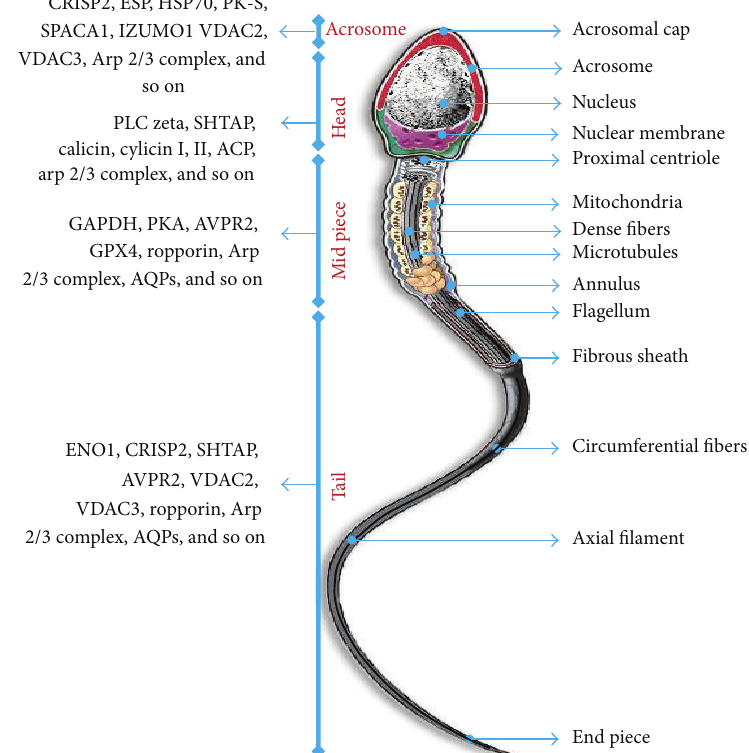
Figure 3: Diagram showing a mature human spermatozoon with its different parts. Previously published studies were used as a reference to summarize the list of proteins localized in different regions of the spermatozoon by immunolocalization. Proteins localized in acrosome, head, midpiece, and tail are mainly involved in capacitation and acrosomal reaction, spermatozoa-oocyte interaction (zona binding), energy production and metabolism, and motility and metabolism, respectively. The localization of a single protein at multiple sites in the sperm cell indicates its potential involvement in different physiological processes of the spermatozoon. The listed proteins include protein kinase A (PKA), phospholipase C zeta (PLC zeta), sperm head- and tail-associated protein (SHTAP), calicin, cylicins I and II, actin-capping proteins (ACP),enolase1(ENO1),cysteine-richsecretoryprotein2(CRISP2),argininevasopressinreceptor(AVPR),voltage-dependentanionchannel (VDAC), glyceraldehyde 3-phosphate dehydrogenase (GAPDH), glutathione peroxidase 4 (GPX4), equatorial segment protein (ESP), heat shock protein 70 (HSP70), novel pyruvate kinase (PK-S), sperm acrosomemembrane-associated protein 1 (SPACA1), izumo sperm-egg fusion 1 (IZUMO1), aquaporin 7 (AQPs), and the actin-related protein 2/3 complex (Arp2/3